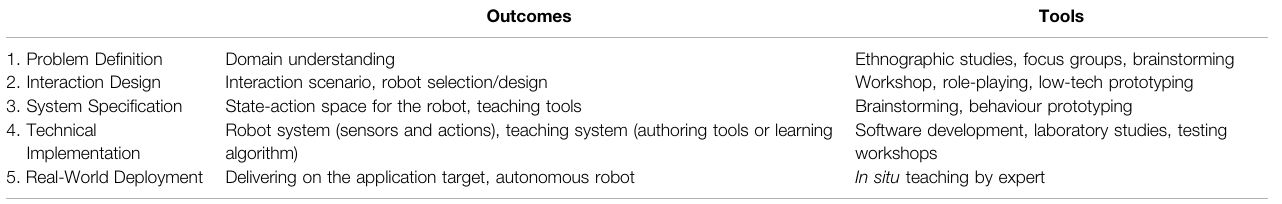
TABLE 1 | Key outcomes of and appropriate tools for each stage of